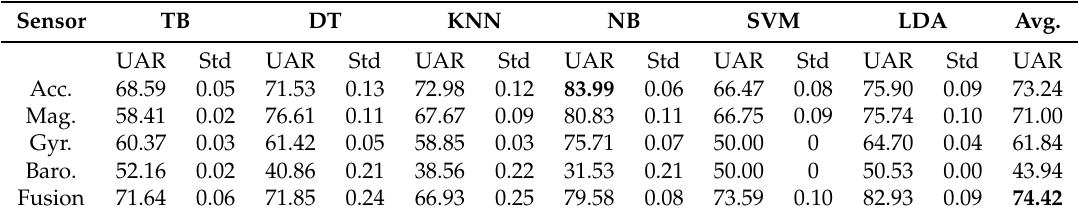
Table 3. Imbalanced Learning method results for non-dominant hand: Unweighted Average Recall (UAR) in % along with the standard deviation (Std) of UAR for each fold (i.e., subject) of classification. The bold figures indicate the best